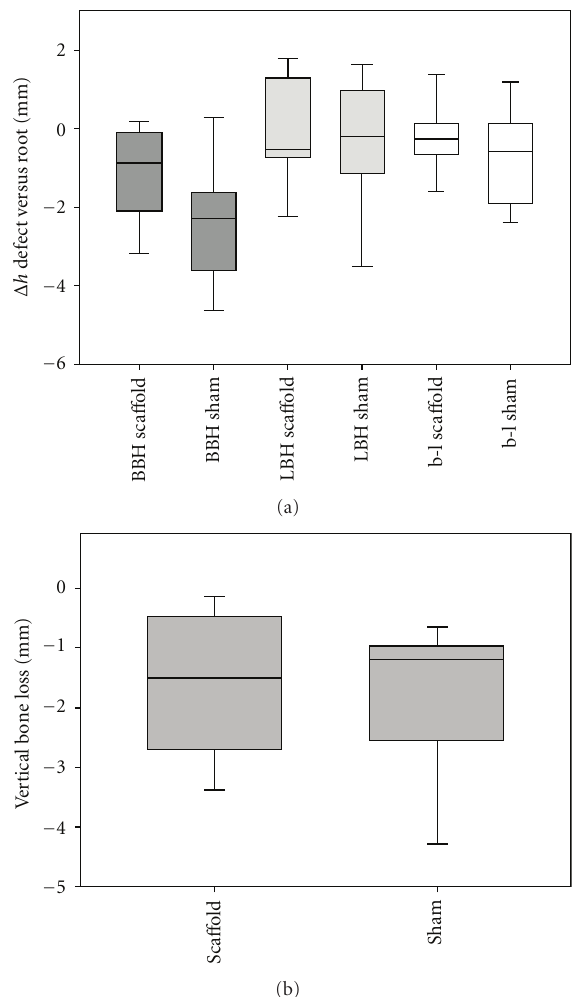
Figure 5: (a) Box plot showing the medians and distributions of the di ff erence in buccal and lingual bone height (BBH and LBH) and height di ff erence of buccal and lingual bone crest (b-l) in comparison to equivalent measurement on the corresponding mesial root of each defect site ( Δ h = defect − root). (b) Box plot of vertical bone loss relative to the original bone level measured from central micro-CT sections cut in the mesial-distal direction. The whiskers of the plots represent the 5th and 95th percentiles, n = 11.